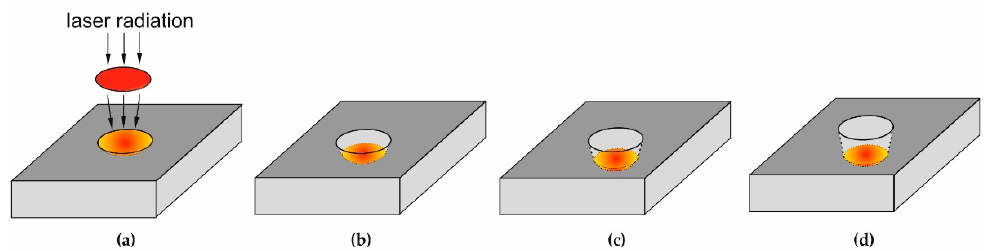
Figure 2. Diagram of stratigraphic measurements made in the LIBS experiment ( a ) initial phase, before laser shot, ( b – d ) sample surface with increasing number of laser shots.